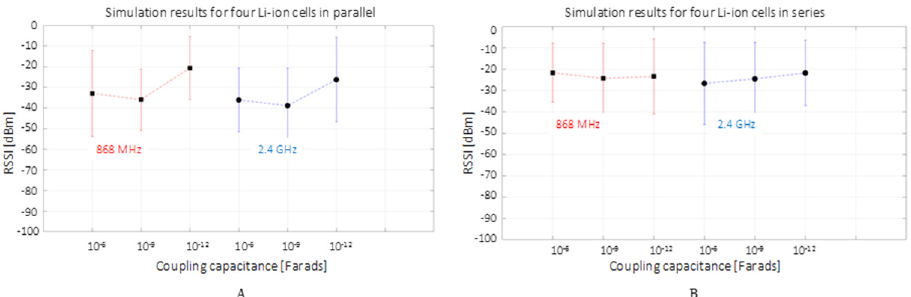
Figure 6. MATLAB simulation received signal strength (RSS) for 868 MHz and 2.4 GHz commu- nication over the DC bus composed of four Li-ion cells organized in parallel ( A ) and in series ( B ). The square marker shows the average measurement interval value in the context of the min–max range bars.